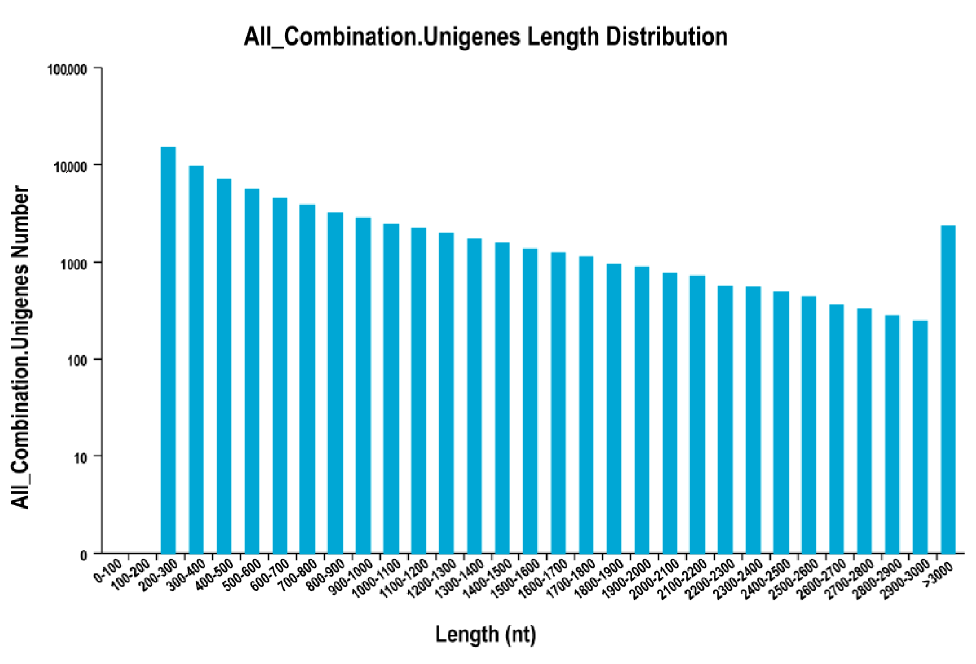
Figure 2. Distribution of unigene lengths from Polygonatum sibiricum .